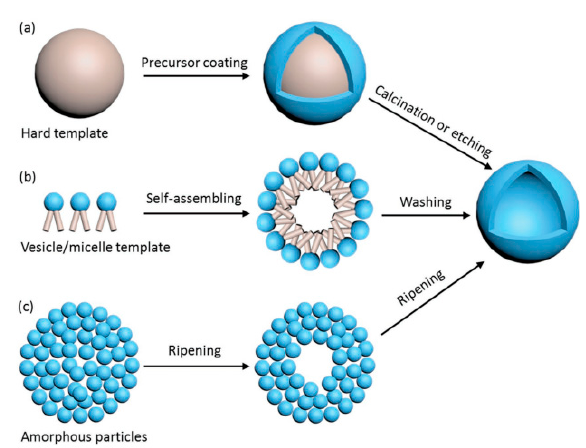
Figure 5. Preparation of TiO 2 hollow spheres via the hard-templating method ( a ), soft-templating method ( b ), and self-templating method ( c ). Reprinted with permission from [21]. Copyright 2018, John Wiley and Sons.